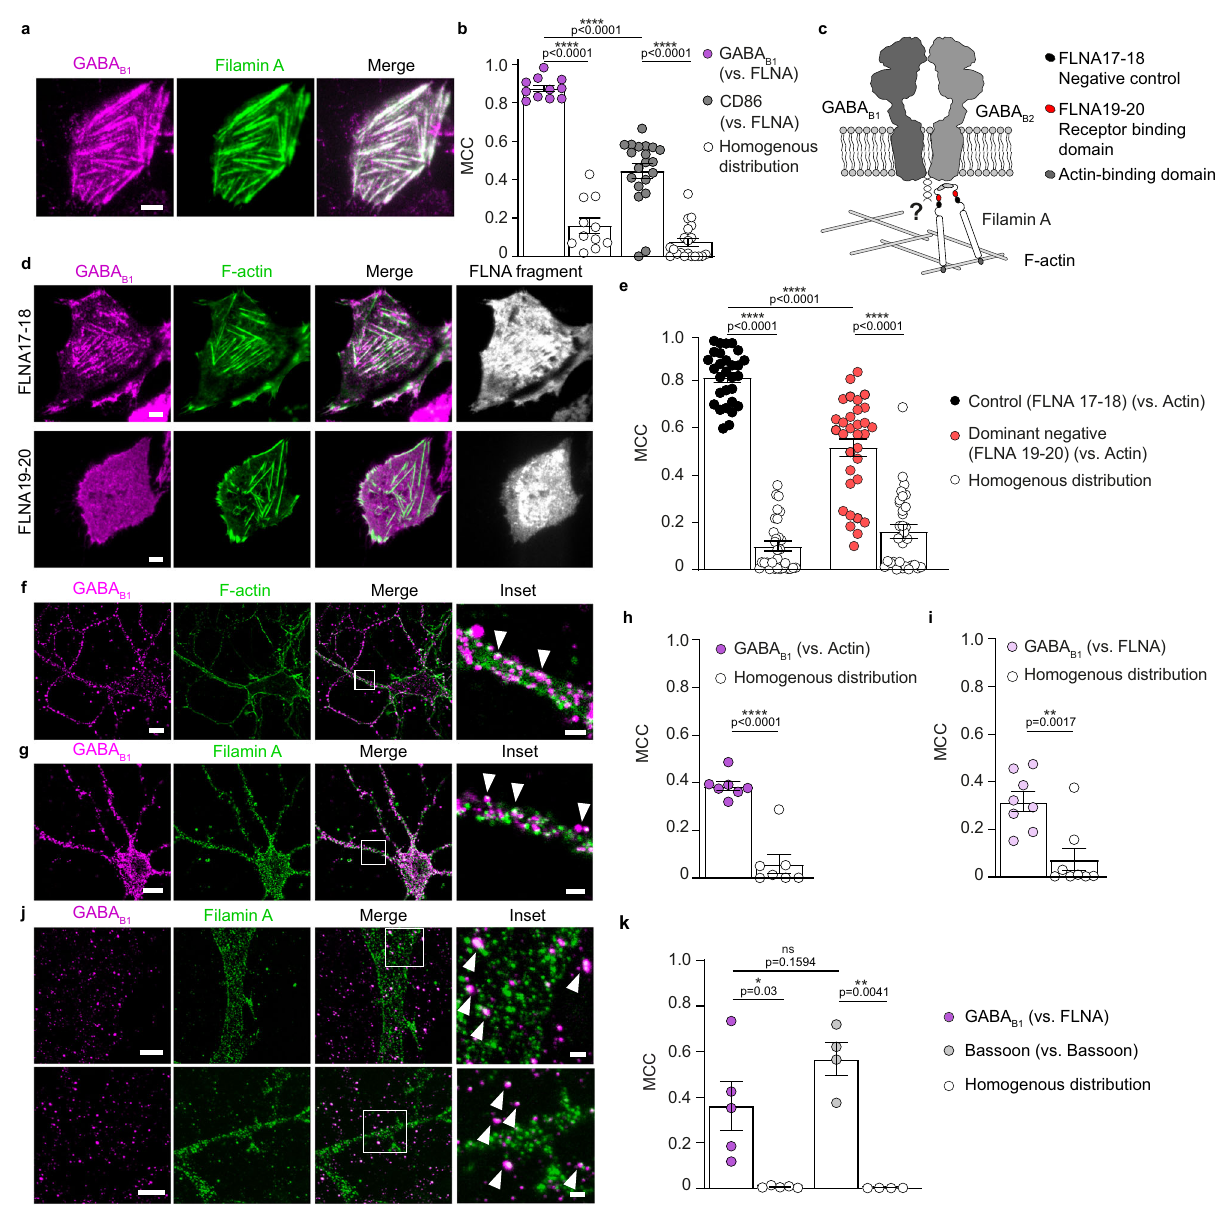
hippocampal neurons immunostained for GABA B1 (magenta) and either actin (green) ( f ) or FLNA (green) ( g ). Insets correspond to the regions delimited by the white boxes. Arrowheads, examples of colocalization. h , i Quanti fi cation of GABA B1 colocalization with actin ( h ) or FLNA ( i ) in hippocampal neurons. Shown are MCC values vs. those of homogenous GABA B1 distributions. Data are mean±SEM. n =7 and 8 cells (actin and FLNA, respectively) examined over three independent experiments. j Maximum-intensity projection of confocal microscopy stacks after 4X expansion microscopy of hippocampal neurons immunostained for GABA B1 (magenta) and FLNA (green). k Quanti fi cation of GABA B1 colocalization with FLNA based on 4X expansion microscopy images. Shown are MCC values vs. those of homogenous GABA B1 distributions. Data are mean±SEM. n =5 and 4 cells (GABA B1 and Bassoon, respectively) examined over two independent experiments. * p <0.05, ** p <0.01, **** p <0.0001 by two-tailed unpaired Welch ’ s t-test. ns statisti- cally not signi fi cant. Scale bars, 5 µ m (images in a , d ), 10 µ m (images in f , g , j ), 2 µ m (insets in f , g , j ). Source data are provided as a Source Data fi